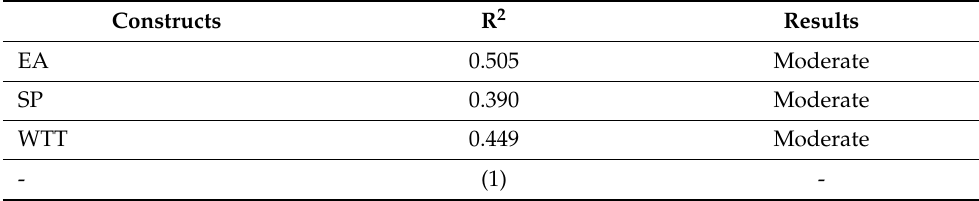
Table 6. R 2 of the endogenous latent